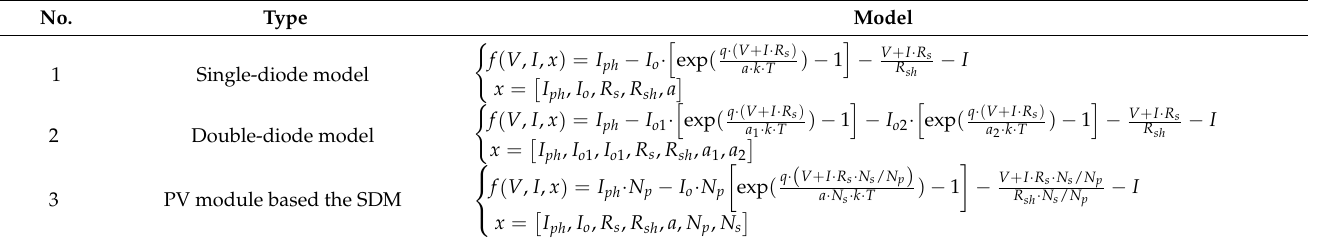
Table 1. Error functions of the three